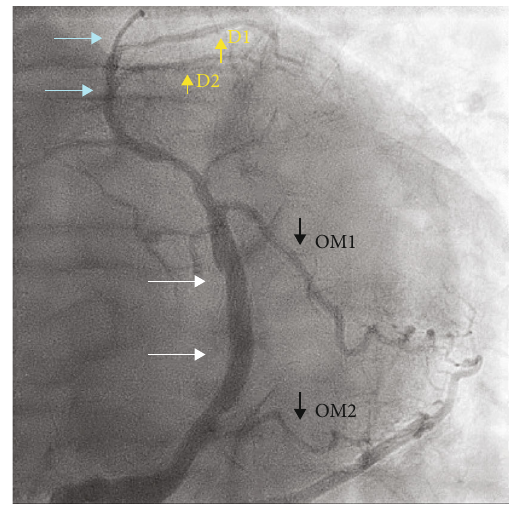
Figure 2: Right coronary angiogram (left anterior oblique 30 ° / cranial 30 ° ) revealing an anomalous LCx artery (white arrows), the second small LAD artery (blue arrows), 1st and second diagonal arteries (yellow arrows), and 1st and second obtuse marginal arteries (blue originating from the right coronary cusp and into the interventricular groove (Figure 3, red arrows; Figure 4, green arrow with asterixis) which is also represented in Figure 1 by the blue arrows.